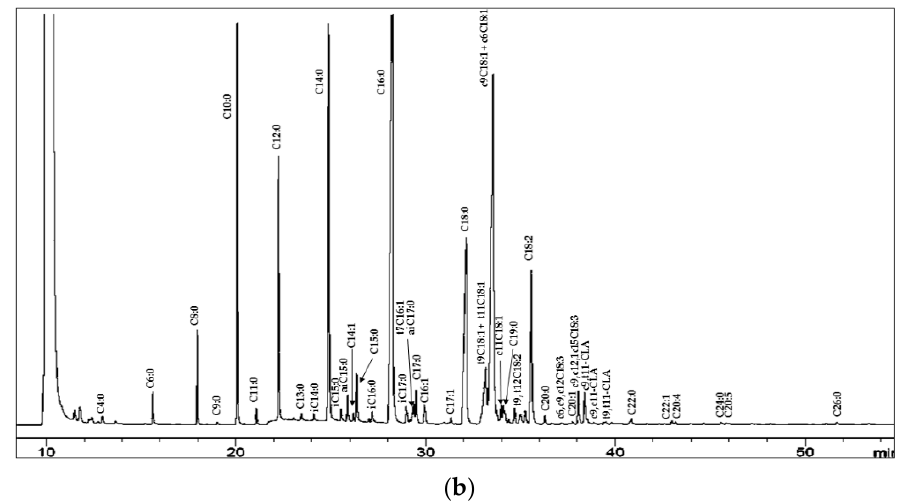
Figure 1. Gas Chromatography-Flame Ionization Detector chromatogram of fatty acids methyl esters of total fatty acids extracted from two different samples of ewes milk. ( a ) separation obtained on a CP7861 column (60 m × 0.25 mm, 0.25 µm, Agilent J&W, Santa Clara, CA, USA). Initial column temperature was held at 40 °C for 2 min, increased to 175 °C at a rate of 10 °C/min and held for 27 min, then increased to 215 °C at 0.5 °C/min. The carrier gas was helium at a flow rate of 1 mL/min, the split ratio was 1:30 and 1 µL of sample was injected. The injector and detector temperatures were 325 and 250 °C, respectively. No peaks were detected after 90 min. ( b ) separation obtained on a CP7489 column (100 m × 0.25 mm, 0.2 µm, Varian Inc., Mississauga, ON, USA). Initial column temperature was held at 60 °C for 5 min, increased to 165 °C at a rate of 14 °C/min and held for 1 min, then increased to 225 °C at 2 °C/min and held steady for 20 min. The carrier gas was helium at a flow rate of 1.2 mL/min, the split ratio was 1:5 and 1µL of sample was injected. The injector and detector temperatures were 325 and 300 °C, respectively.